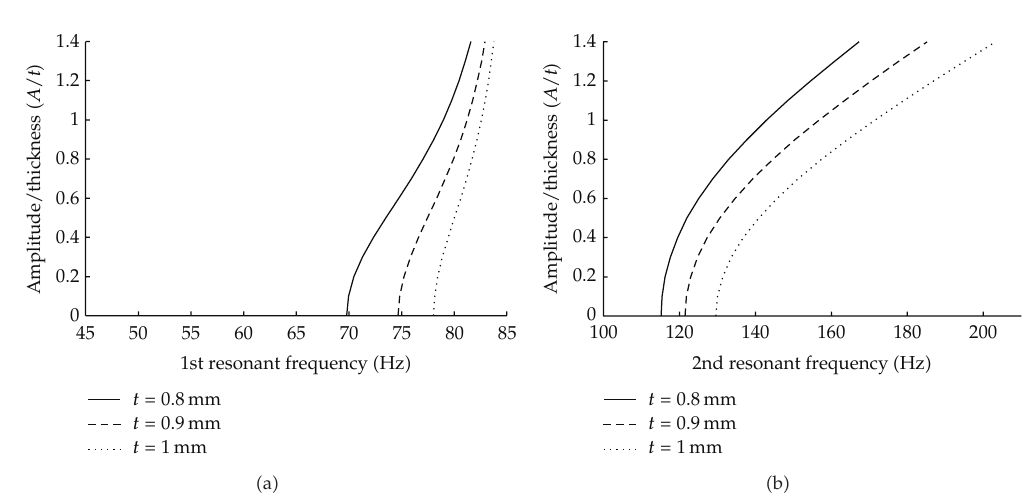
Figure 3: (cid:3) a (cid:6) The vibration amplitude ratio versus the 1st nonlinear resonant frequency (cid:3) t (cid:7) 0 . 8, 0.9, 1mm (cid:6) . (cid:3) b (cid:6) The vibration amplitude ratio versus the 2nd nonlinear resonant frequency (cid:3) t (cid:7) 0 . 8, 0.9, 1mm (cid:6) .